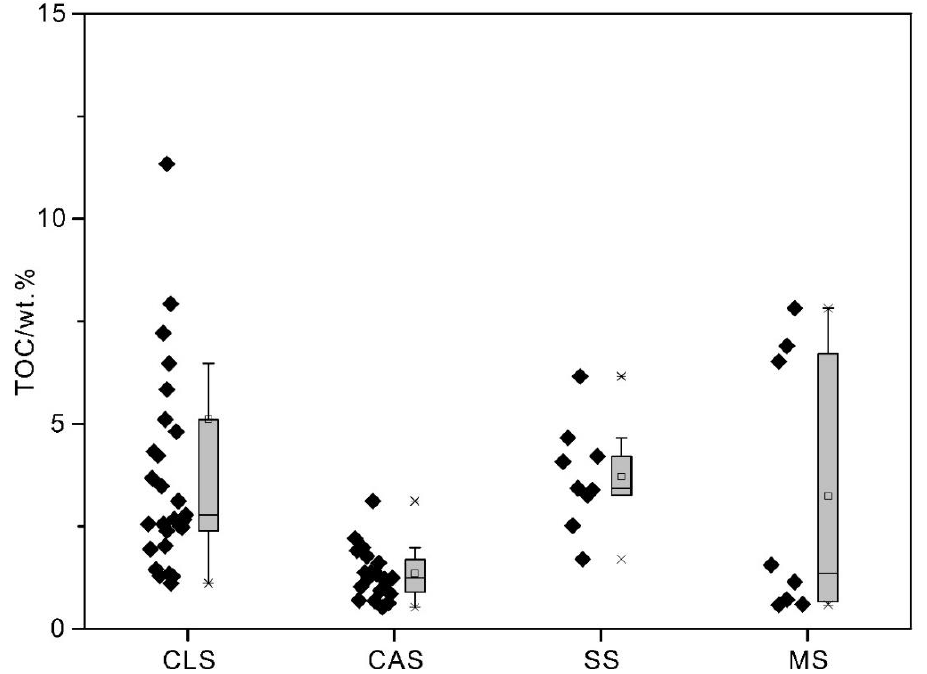
Figure 7. TOC value distribution of different Longtan shale types.